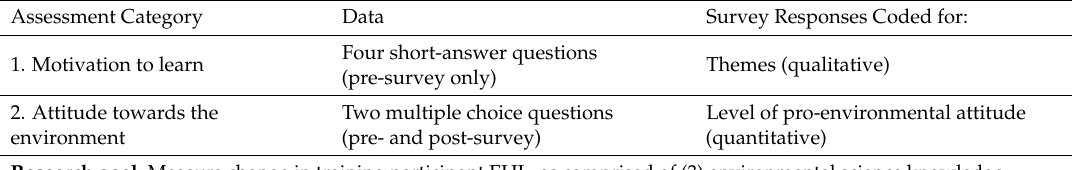
Table 3. Research goals and associated data analysis